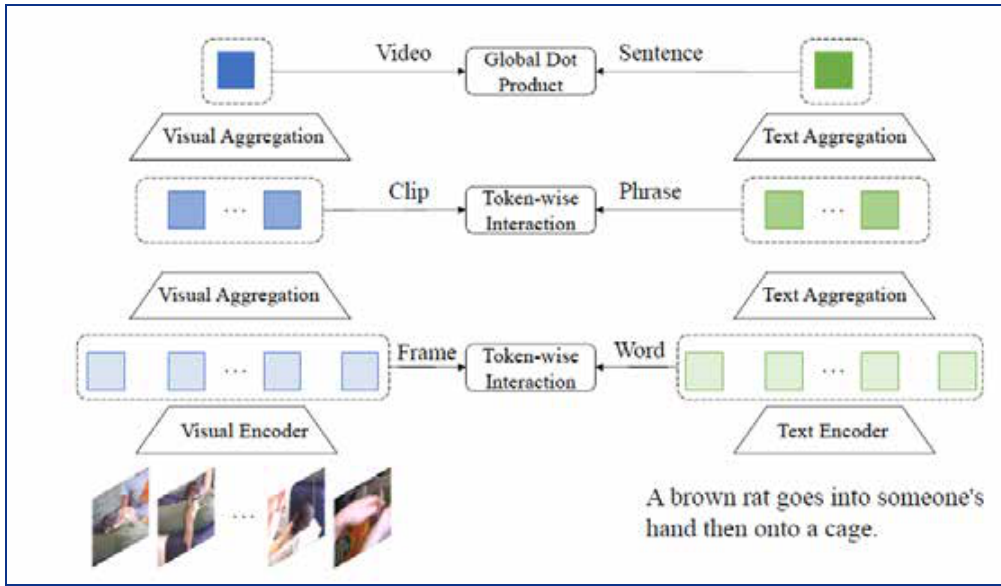
Figure 12 HunYuan_tvr exploration of the relationship between different levels of cross-modality